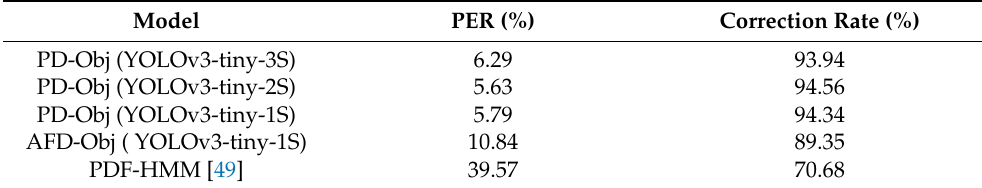
Table 7. PER and correction rate of the Arabic phoneme recognition using the proposed models. Model